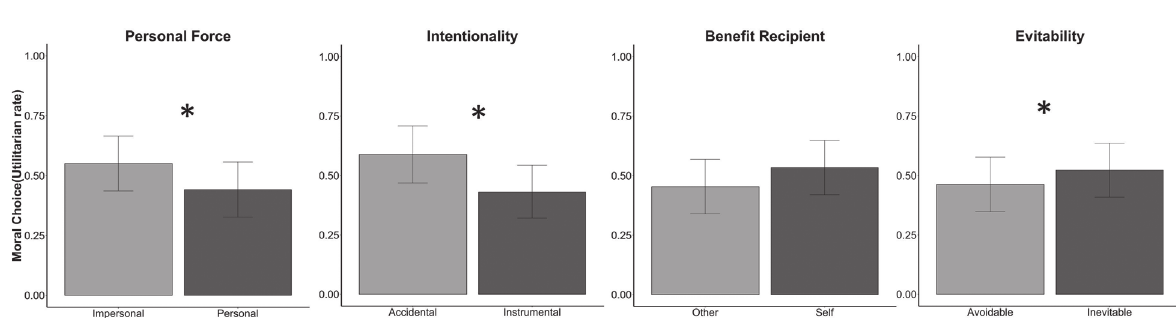
Figure 4. Utilitarian response rates distribution per conceptual factors. Error bars represent CI of LMM model. Significant differences ( P < 0.05) are indicated via *.